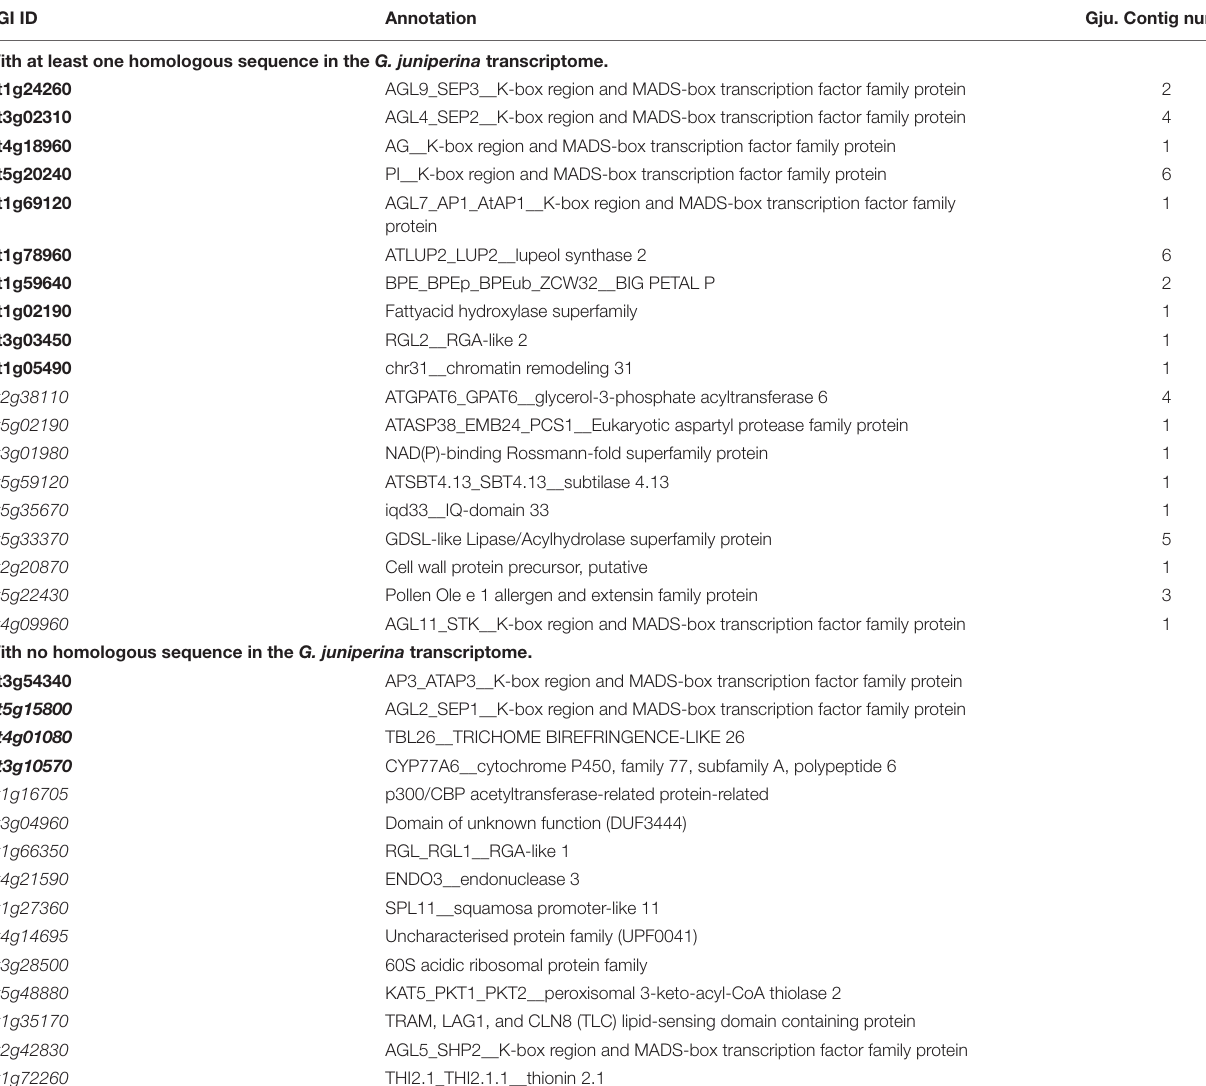
TABLE 1 | List of genes co-expressed with the ABCE MADS-box genes in Arabidopsis thaliana ( r -value ≥ 0.75, in bold the 14 AGI-ID with an r -value ≥ 0.8; AGI ID, Arabidopsis Genome Initiative, gene identifier). AGI ID Annotation Gju. Contig number With at least one homologous sequence in the G. juniperina